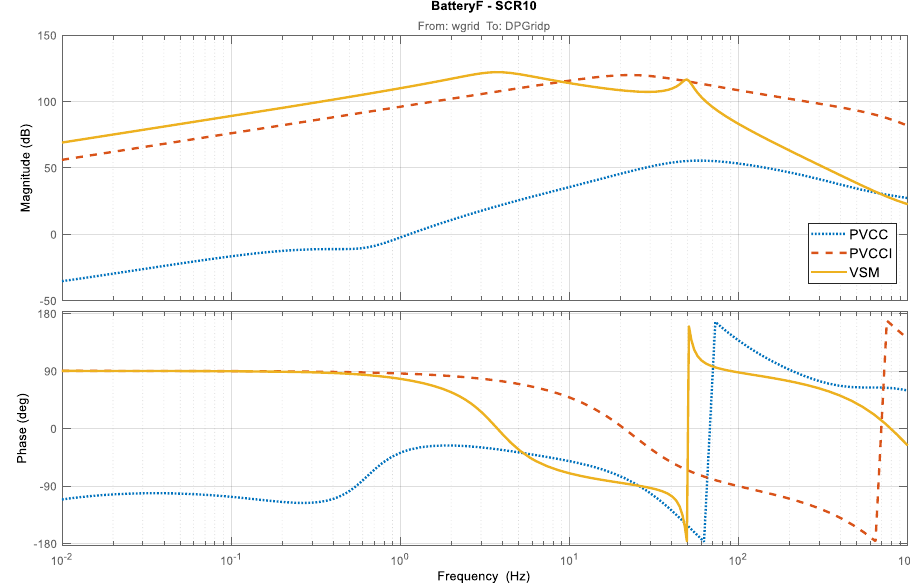
Figure 12. Bode plots comparing the frequency response of each control topology.